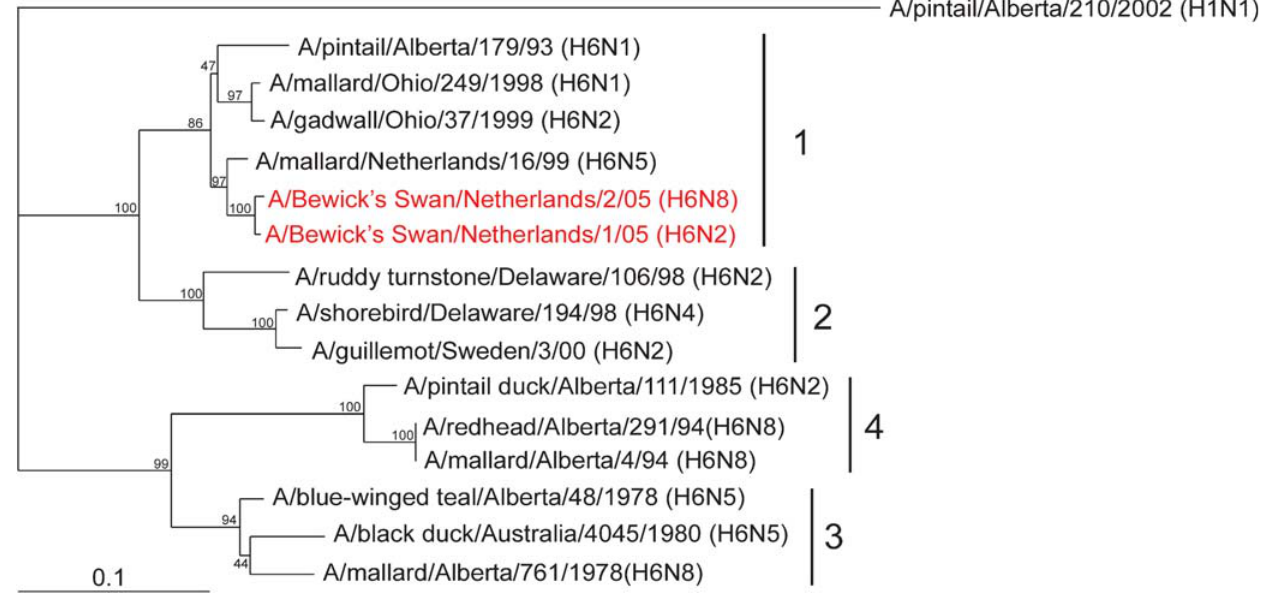
Figure 2. Phylogenetic tree for H6 influenza A viruses isolated from swans. The DNA maximum likelihood tree was constructed using A/pintail/ Alberta/210/2002 (H1N1) as out-group and includes sequences from public databases. Genes clustered into four different groups as described by Spackman et al. [7]. The scale bar represents , 10% of nucleotide changes between close relatives. Small numbers in the tree represent the bootstrap values.